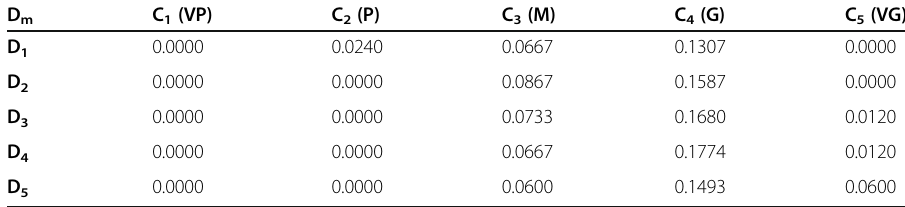
Table 5 The weighted normalized decision matrix D